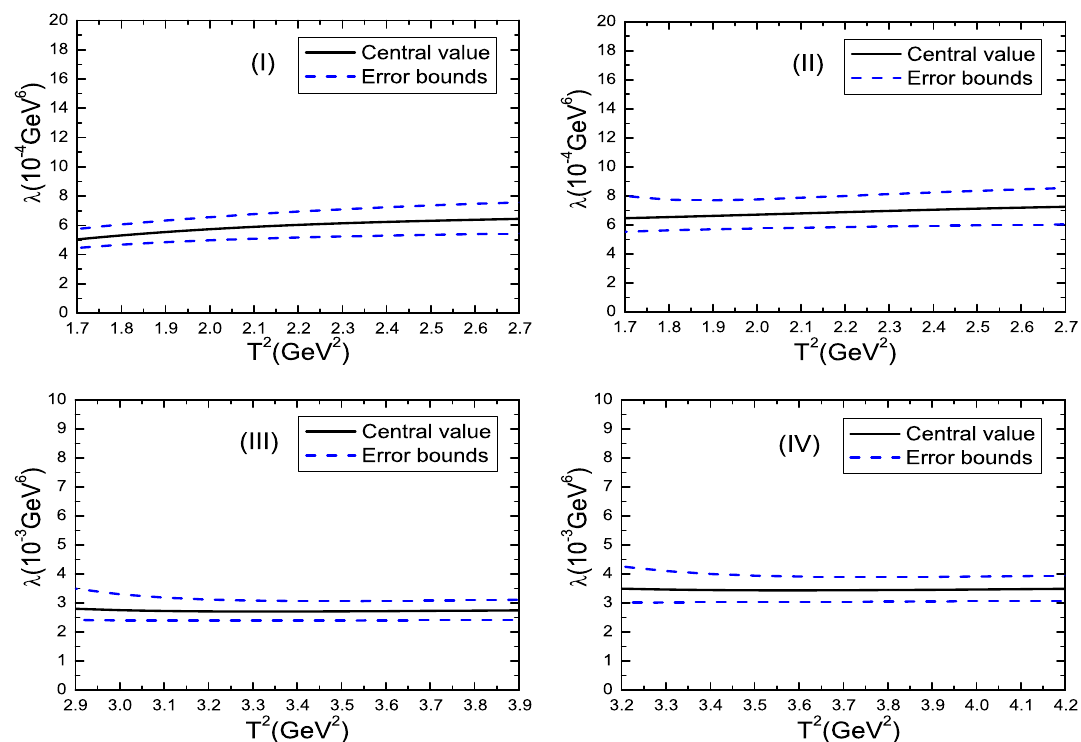
Fig. 5 The pole residues of the charmed pentaquark states with variations of the Borel parameters T 2 for the parameters A , where the (I), (II), (III) and (IV) correspond to the quantum numbers ( uuuc ¯ u , 3